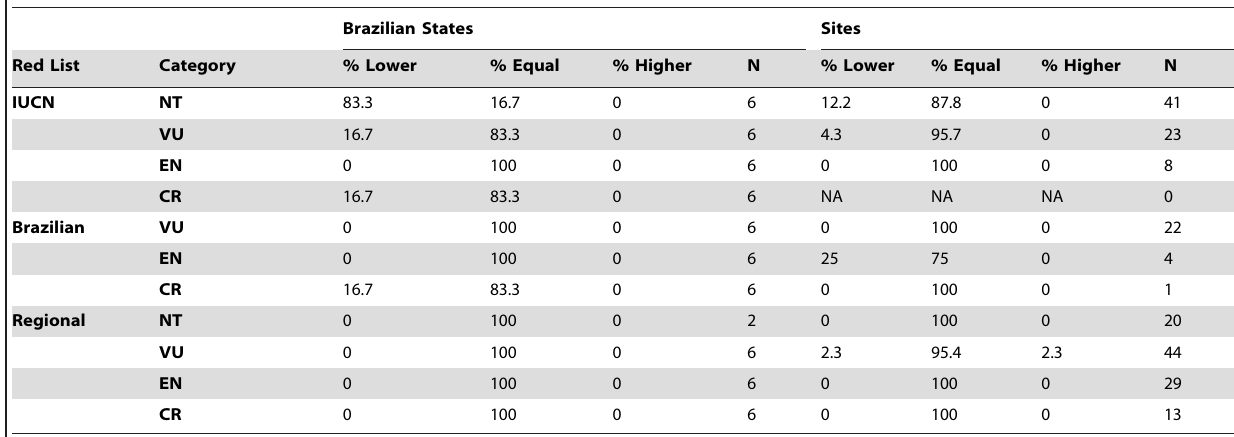
Table 1. Percentage of analyzed Brazilian States and sites with threatened birds in categories of the IUCN, Brazilian and respective States Red Lists which had values of observed functional diversity lower, equal or higher than expected by chance (see Supplementary Material for more information).